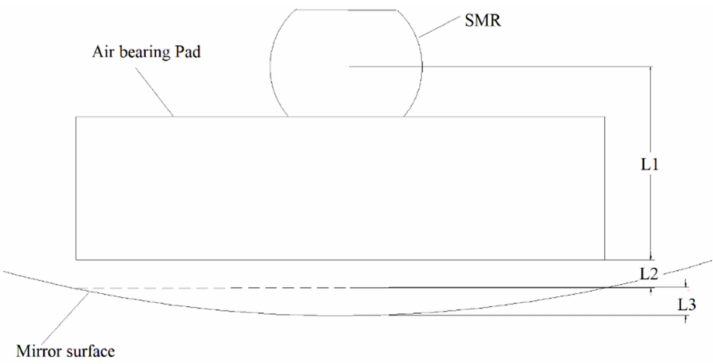
Figure 5. Schematic representation of the composition of probe